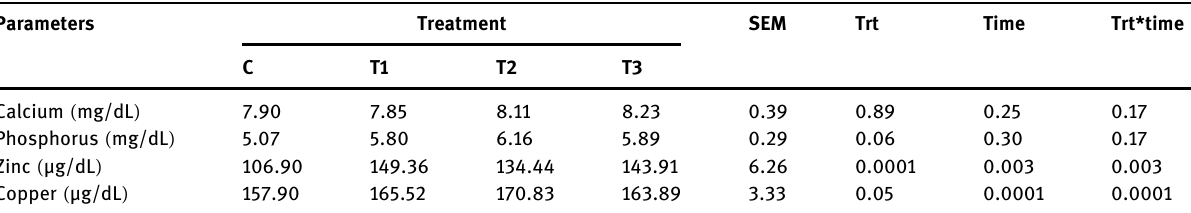
Table 6: E ff ect of DFM supplementation to Najdi newborn lambs, time of sampling, and interaction with blood serum minerals during the feeding trial